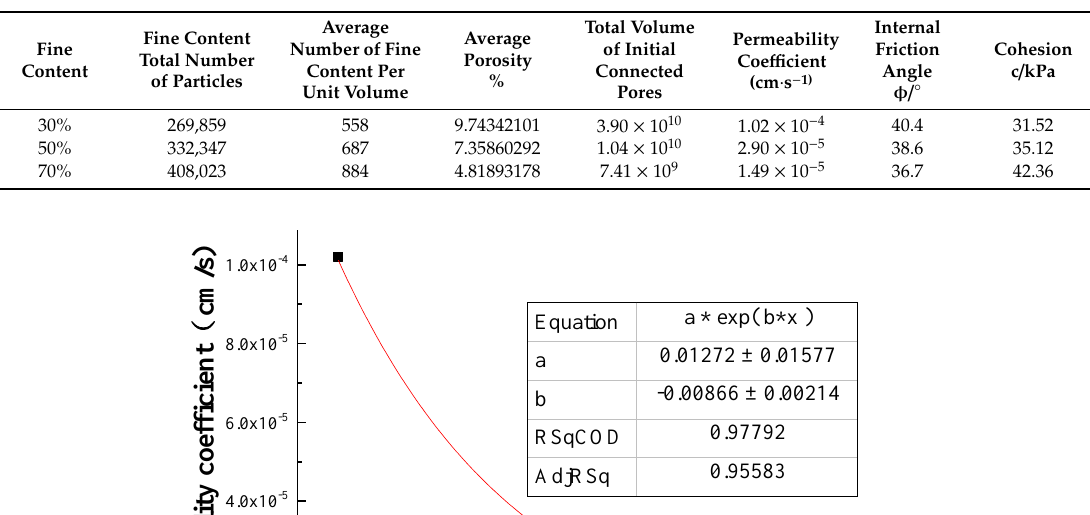
Table 24. Macro- and mesofactor comparison table.